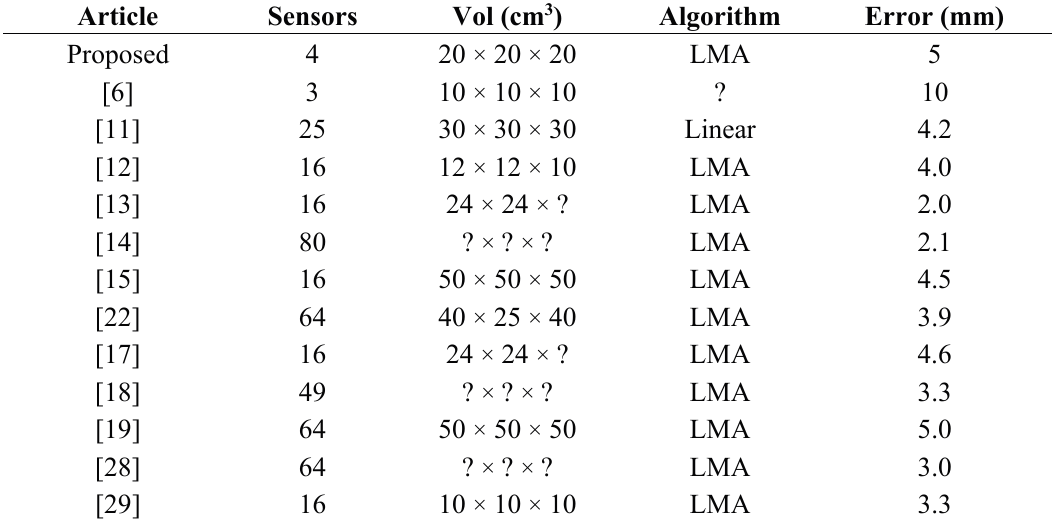
? indicates unknown dimension or missing information; LMA stands for Levenberg-Marquardt